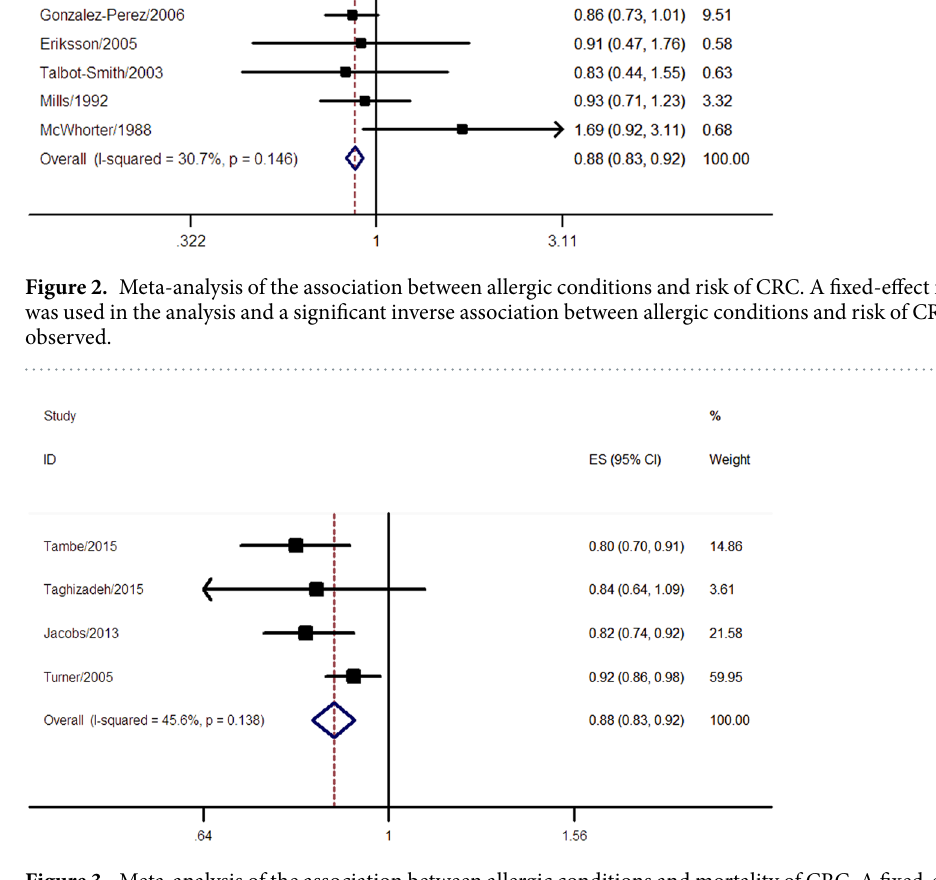
Figure 3. Meta-analysis of the association between allergic conditions and mortality of CRC. A fixed-effect model was used in the analysis and a significant inverse association between allergic conditions and mortality of CRC was